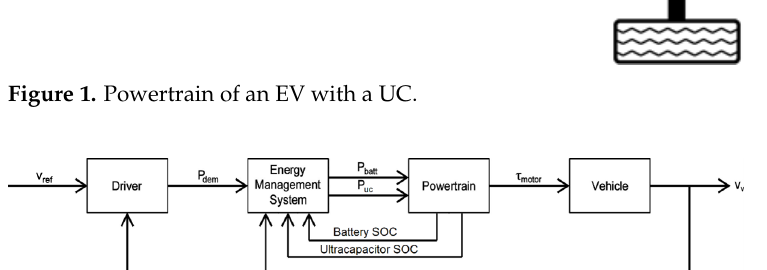
Figure 2. Block diagram for energy management of an EV with a